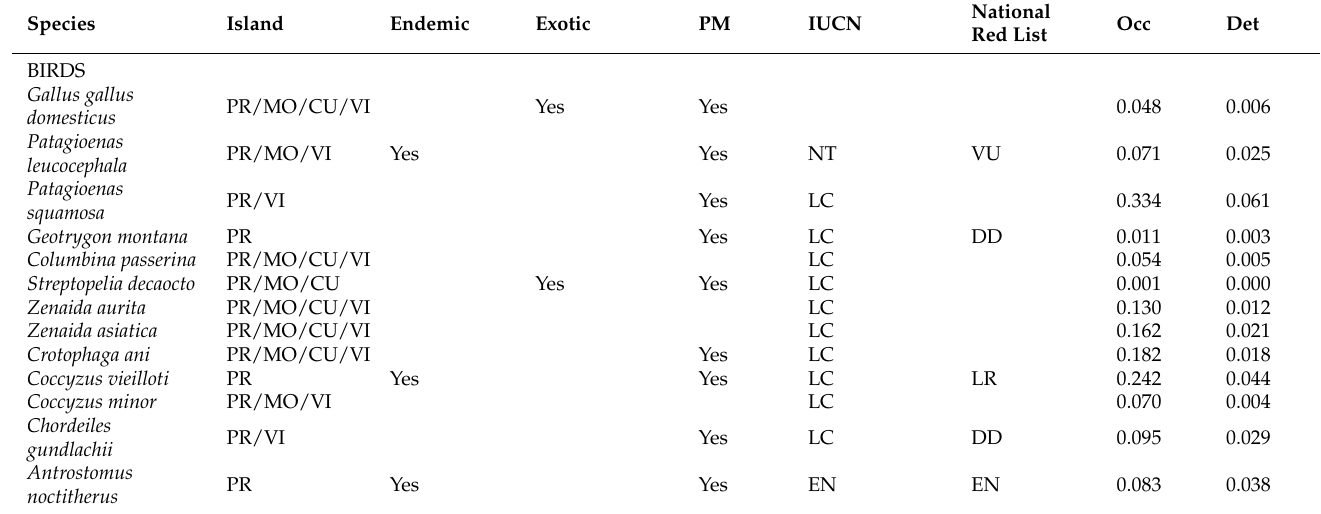
Table A1. Table of 95 species detected (74 birds, 18 frogs, and 3 mammals) through passive acoustic monitoring (combination of manual annotations and Arbimon Pattern Matching analysis) across the 841 sampling sites in Puerto Rico. PM = Pattern Matching, indicating the species with PM analysis; IUCN = International Union for Conservation of Nature; CR = critically endangered; EN = endangered; VU = vulnerable; NT = near threatened; LC = least concern; PR = Puerto Rico main island; CU = Culebra; MO = Mona; VI = Vieques; National Red List = PRSWAP 2018; Occ = naive occu- pancy (proportion of sites where the species was detected); Det = detection